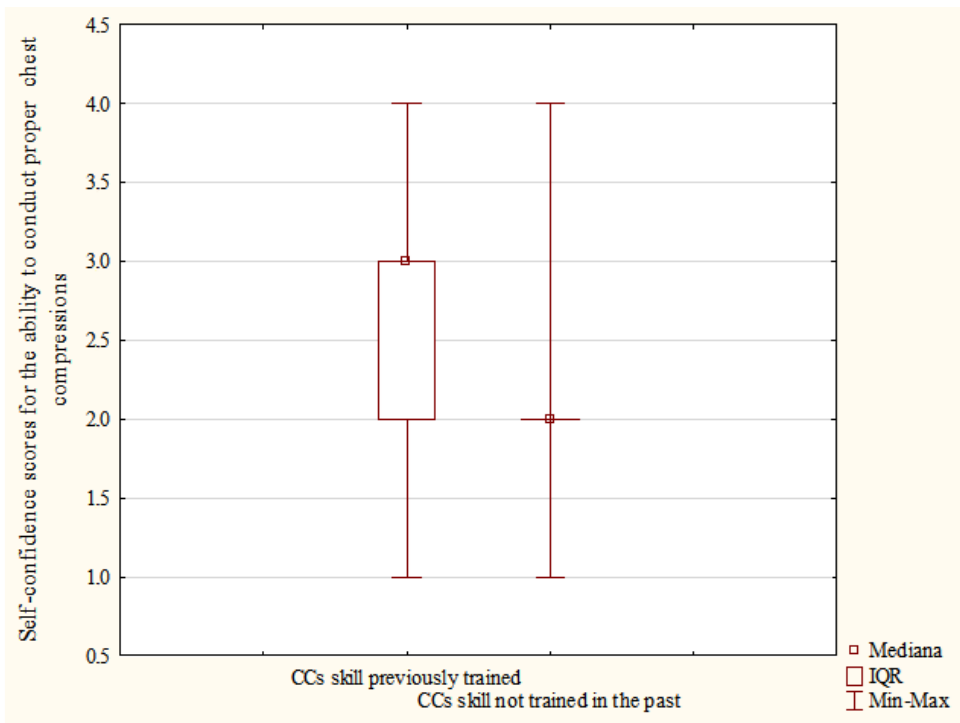
Figure 3. Self-confidence scores-performing proper chest compressions between respondents who previously practiced chest compressions (skill CCs) on a manikin and those who did not pre-test data. Table 3. Comparison of the pre-test and post-test results on the number of participants (n = 967) who declared that they would undertake CPR on individual victims (family member, child, person you know, stranger) multiple choice